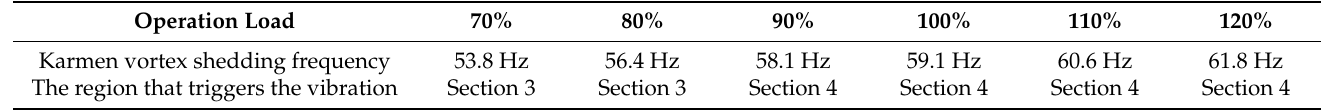
Table 4. The numerical simulation calculation results of Karmen vortex shedding frequency in different operation conditions.